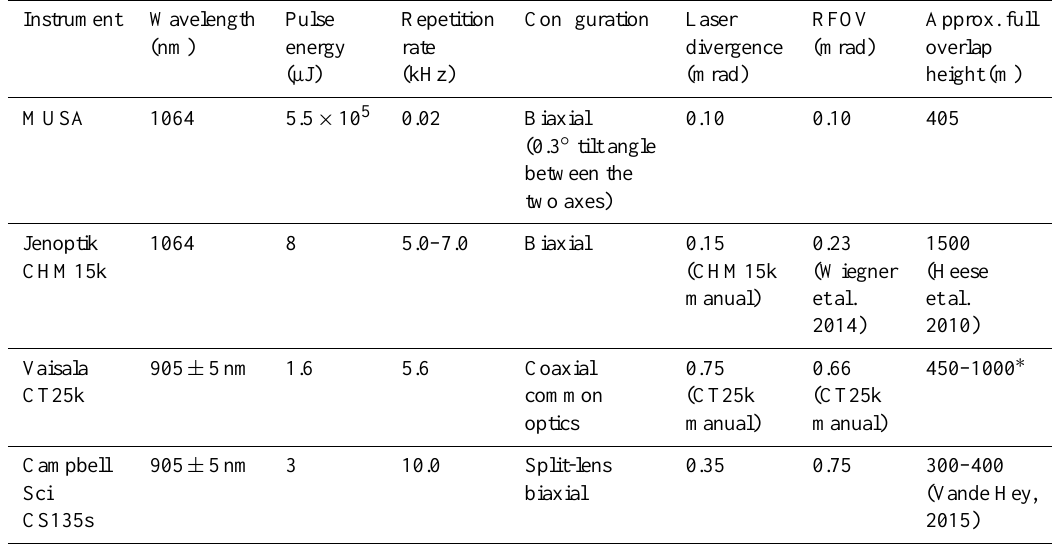
Table 1. Specifications of the MUSA lidar at 1064nm and of the three ceilometers. RFOV indicates the half-angle rectangular field of view of the